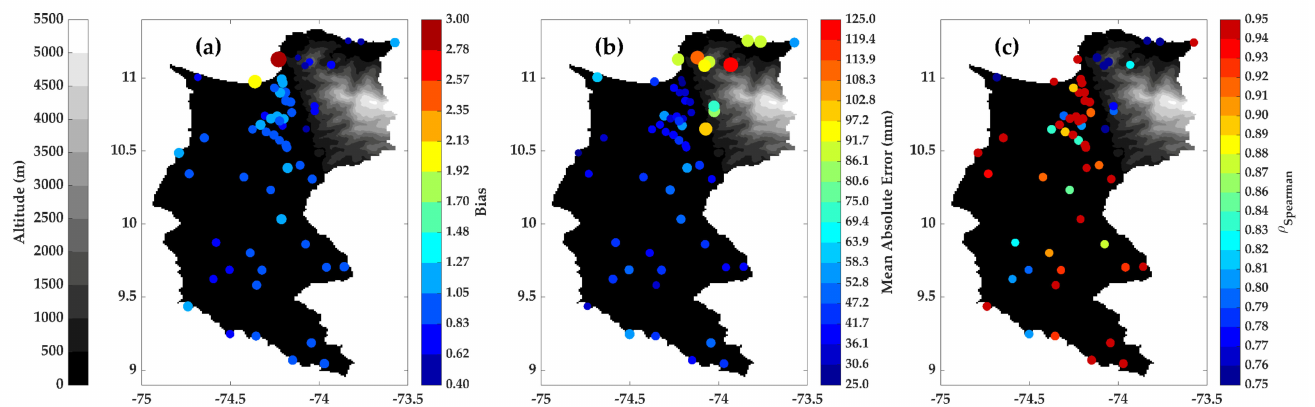
Figure 3. Maps of the statistical metrics employed for evaluating the correspondence between the IDEAM and the CHIRPS v2.0 datasets for the 1981–2018 period at different points in the Magdalena Department: ( a ) bias; ( b ) mean absolute error (mm); ( c ) Spearman’s rho